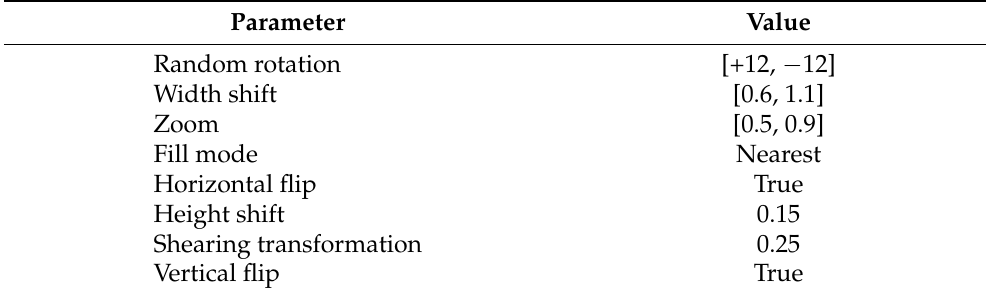
Table 2. Tomato details of data augmentation in the training